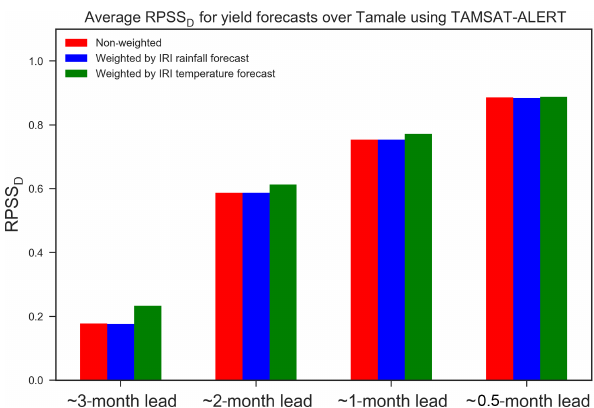
Figure 19. Discrete ranked probability skill score for the yield fore- casts over Tamale using the TAMSAT-ALERT system at different lead times averaged for